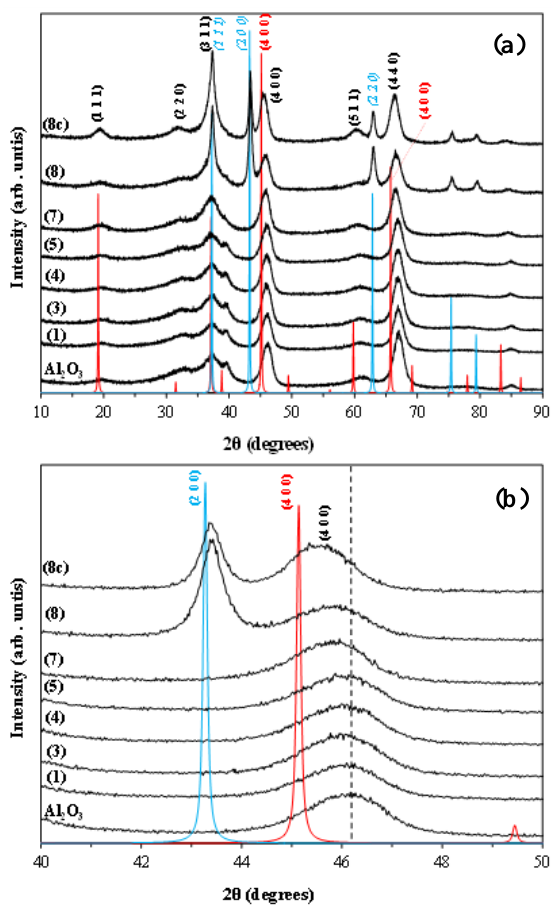
Figure 6. ( a ) PXRD patterns of Al 2 O 3 -CH-Ni-oc- X samples, prepared via impregnation of γ -Al 2 O 3 with Ni octanoate solution diluted in cyclohexane (see experimental section); X : ( 1 ) 1000 ppm Ni, ( 3 ) 5000 ppm Ni, ( 4 ) 10,000 ppm Ni, ( 5 ) 15,000 ppm Ni, ( 7 ) 100,000 ppm Ni, ( 8 ) 200,000 ppm Ni, and ( 8c ) sample with 200,000 ppm Ni calcined at 805 °C, 12 h, in addition to the typical calcination at 700 °C, 3 h. ( b ) Enlarged view in the range 40 – 50° 2 θ (the dashed line indicates the center of the reflection attributed to γ -Al 2 O 3 ). The patterns of NiO (blue pattern) and NiAl 2 O 4 (red pattern) are also shown for comparison.